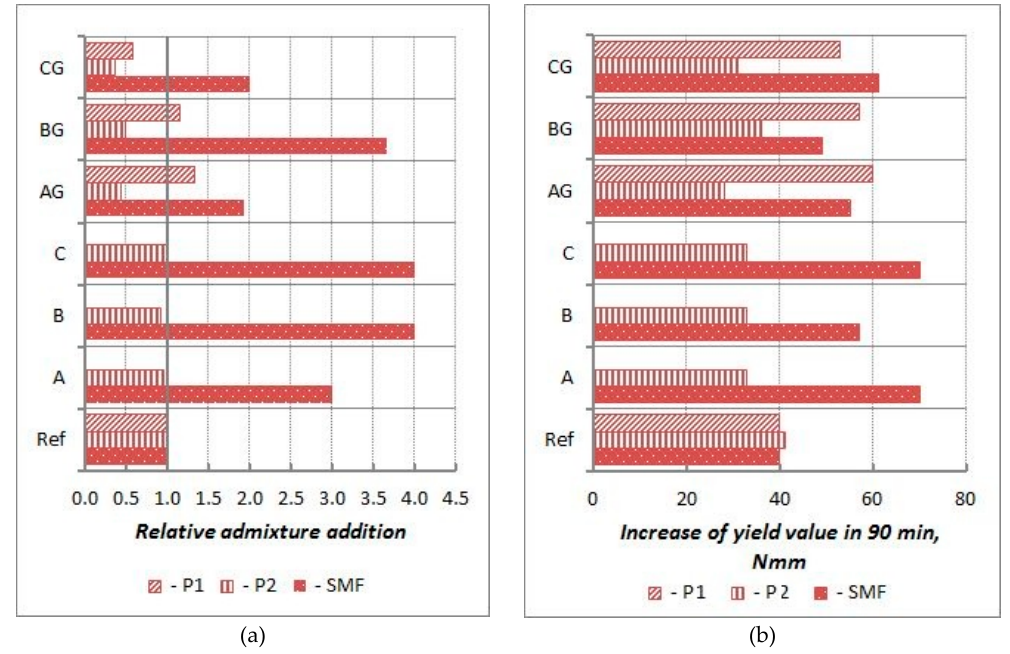
Figure 14. Influence of CFA on effectivness of P1, P2 and SMF (mortars of w/b = 0.55); ( a ) relative admixture content (in relation to reference mortar without CFA) neccessary to be added to obtain mortar with g5 = 20 Nmm; ( b ) increase in yield value g of mortars with initial yield value g equal 20 Nmm in time.